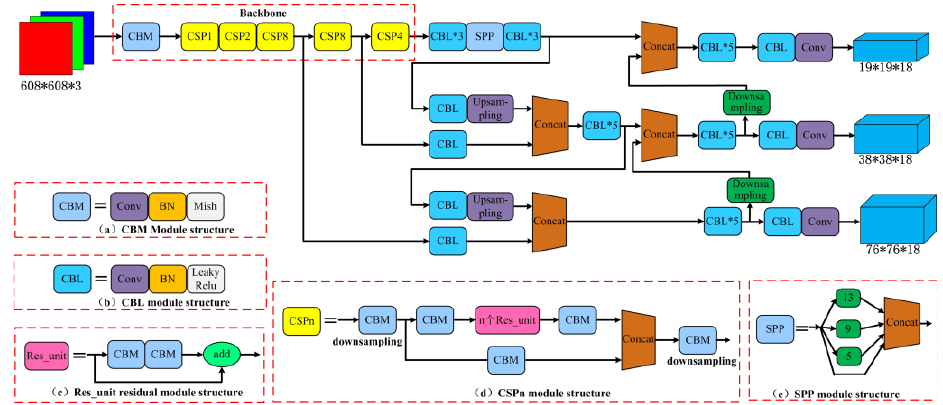
Figure 3. The network structure of the YOLOv4 target detection model.